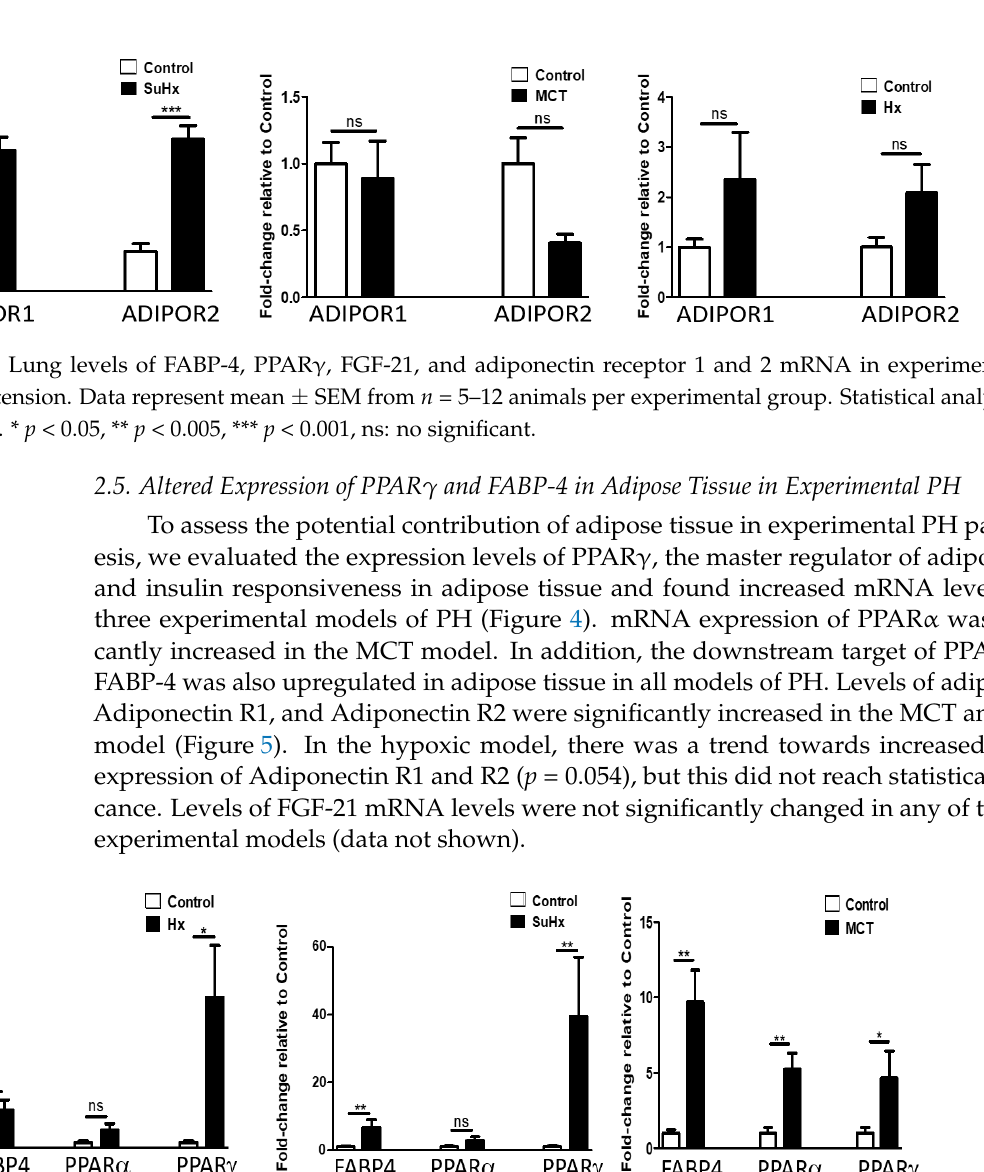
Figure 5. Altered adipose tissue levels of Adiponectin and Adiponectin receptor 1 and 2 mRNA in experimental pulmo- nary hypertension. Data represent mean ± SEM from n = 8 – 14 animals per experimental group. Statistical analysis by Student’s t -test. * p < 0.05, ** p < 0.005, *** p < 0.001, ns: no significant. 2.6. Metabolic Pathway Gene Expression is Altered in Rat Adipose Tissue in Experimental PH To evaluate the metabolic state of adipose tissue during experimental PH we assessed mRNA levels of genes involved in glycolysis, the TCA and FAO. Glucose uptake and gly- colysis: as shown in Figure 6, levels of Glucose transporter 4 (Glut-4) mRNA, the glucose transporter that facilitates insulin-stimulated glucose uptake, were significantly increased in the SuHx and MCT models and a non-significant trend was noted in the hypoxic model. Interestingly, insulin-independent Glut-1 mRNA expression was only significantly in- creased in the hypoxic model, while no significant difference was determined in the SuHx- or MCT-induced PH. However, mRNA levels of Phosphofructokinase-1(PFK-1), one of the key regulatory and rate limiting steps in glycolysis were significantly increased in ad- ipose tissue in all three models of PH.